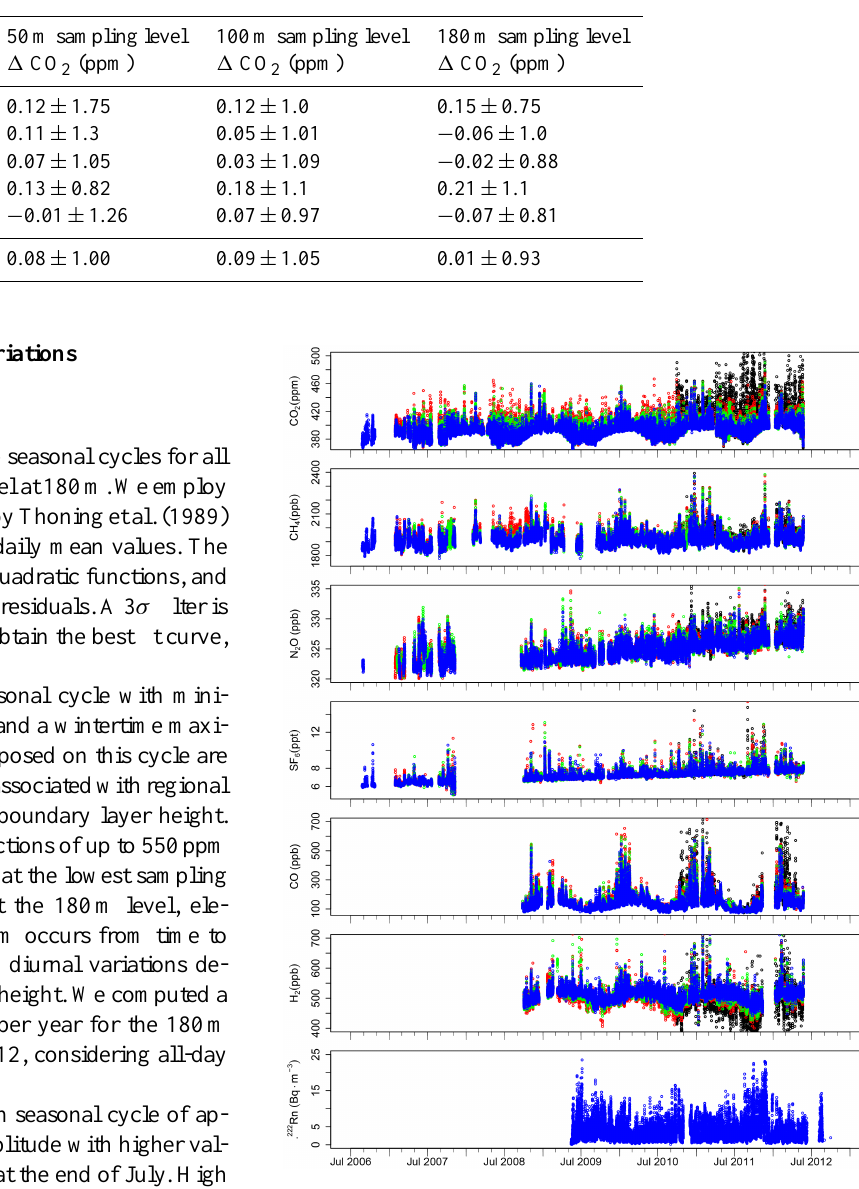
Figure 6. Time series of atmospheric CO 2 , CH 4 , N 2 O, SF 6 , CO, H 2 and 222 Rn measurements from the 180m (blue), 100m (green), 50m (red) and 5m (black) inlet line. From November 2007 to September 2008 the N 2 O and SF 6 measurements were interrupted due to broken ECD. CO, H 2 and 222 Rn analysers were installed in 2008 and 2009 at the